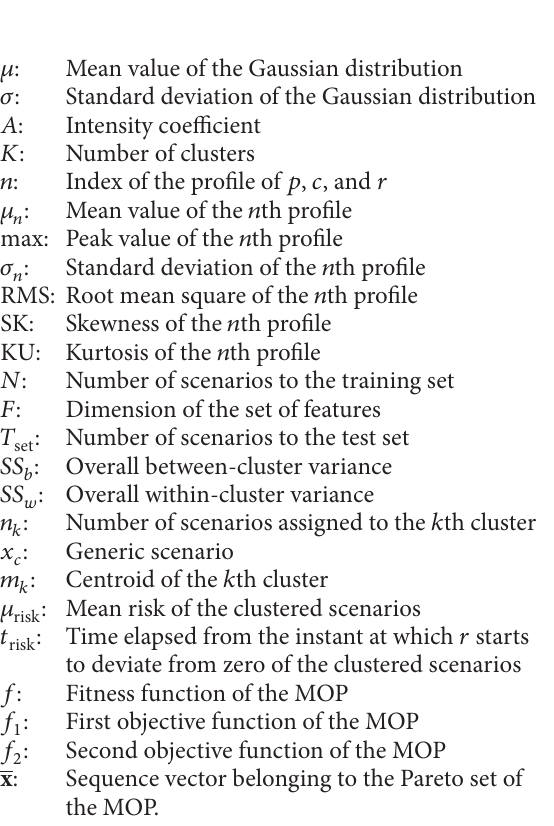
Figure 22: Fault tree for the low level failure mode at high